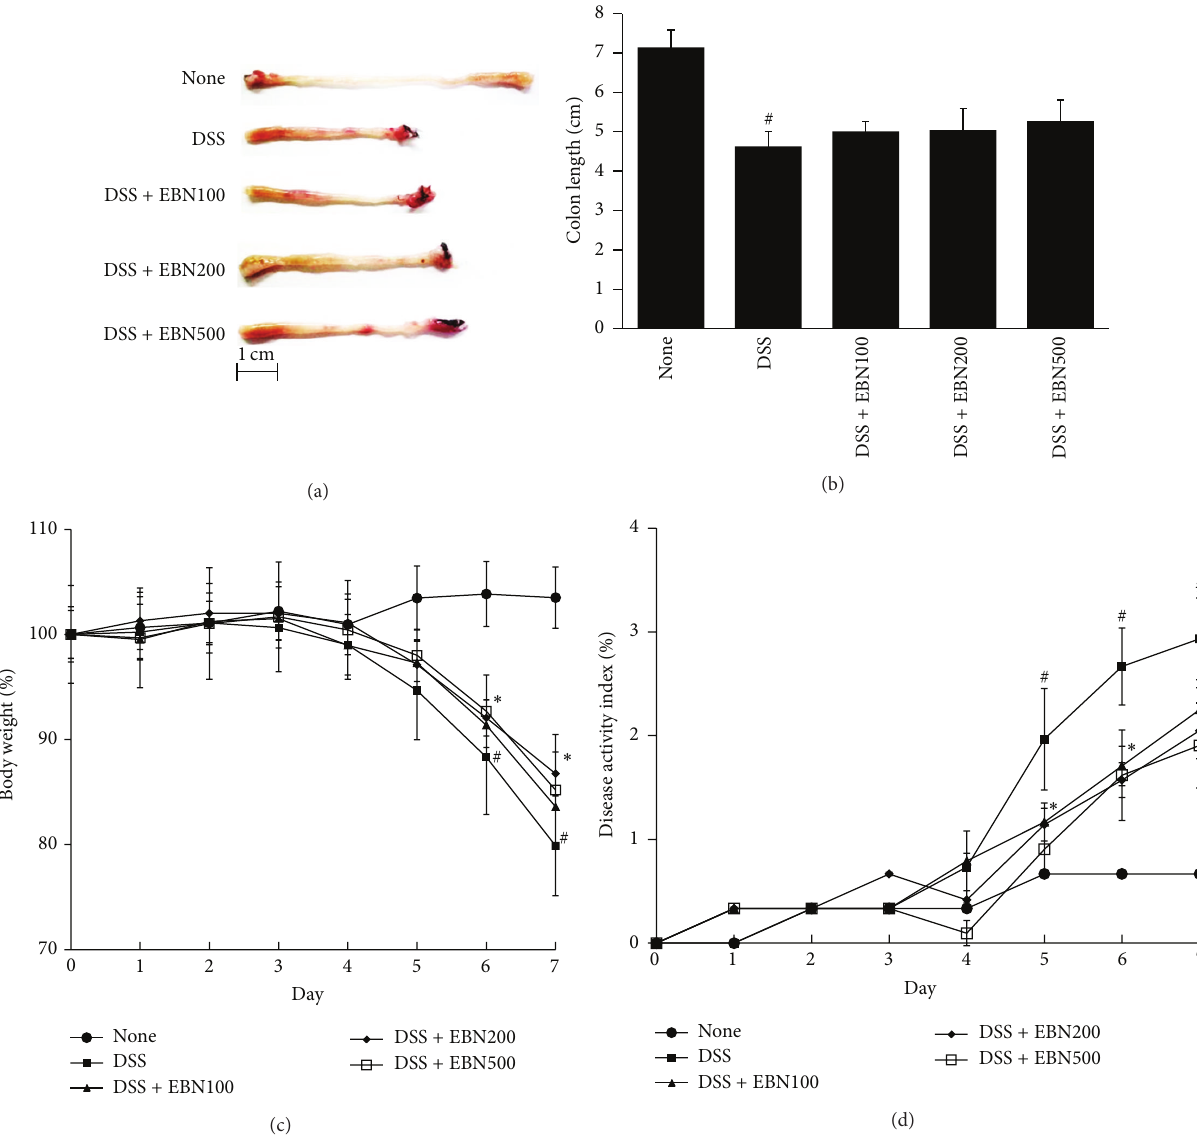
Figure 1: The effect of ethanol extract derived from B. nivea (EBN) on colon length, body weight, and disease activity index (DAI) in dextran sulfate sodium- (DSS-) induced colitis mice. Mice colons were isolated 7 days after DSS administration and their lengths were measured ((a) and (b)). Body weight was measured daily (c). Clinical scores of each mouse were monitored daily (d). Data from 3 independent experiments is shown and expressed as the mean ± SD ( 𝑛 = 8 per group). ∗ 𝑃 < 0.05 versus DSS-treated; # 𝑃 < 0.05 versus